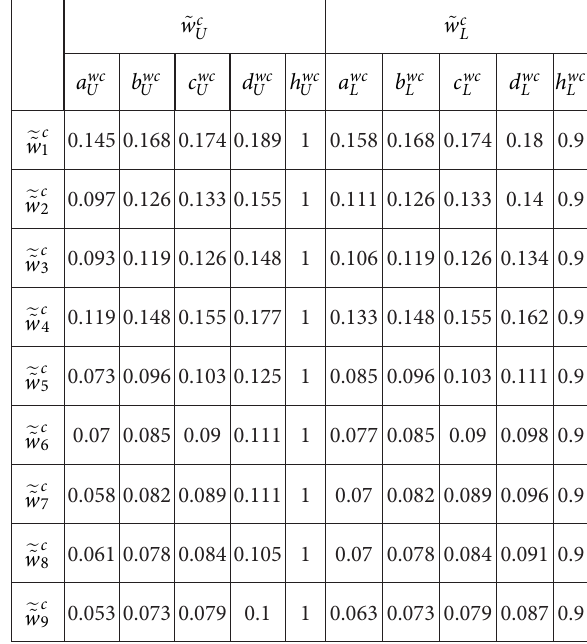
Table 6. The combined weights of criteria